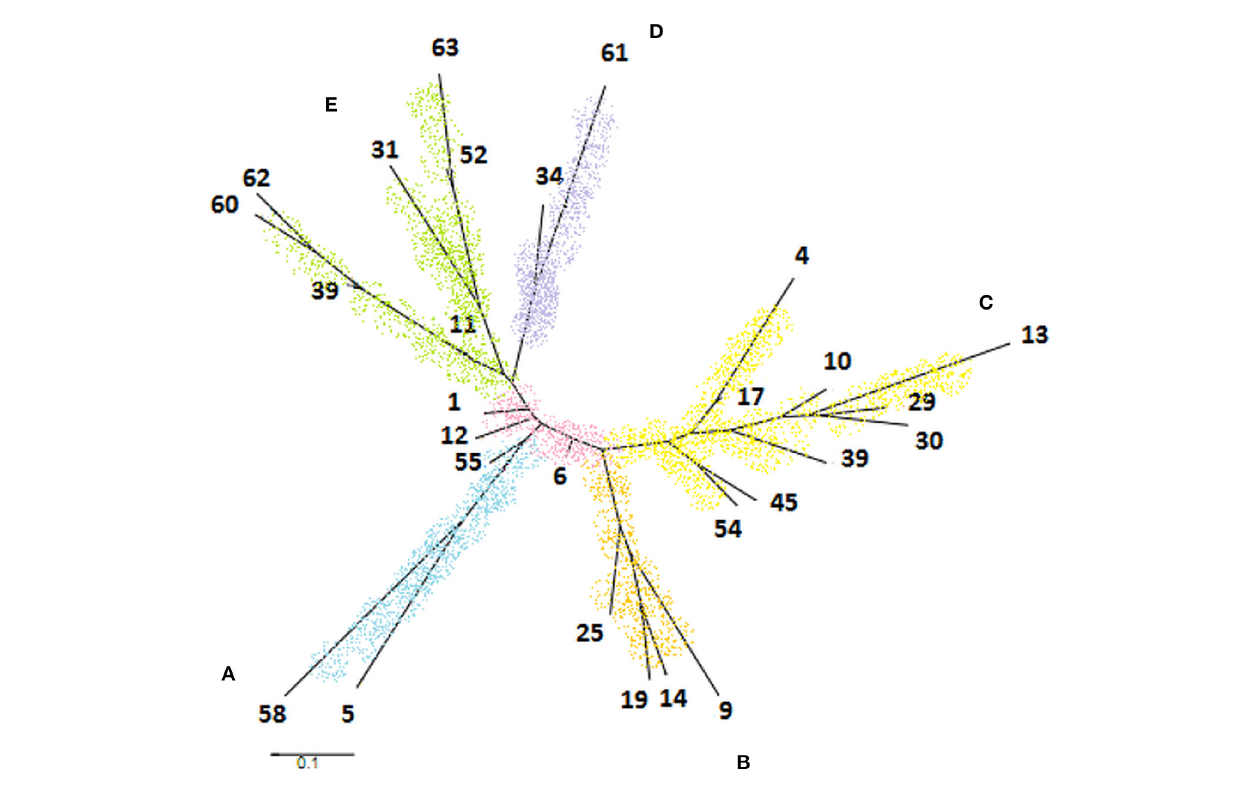
FIGURE 4 | Phylogenetic tree generated by PubMLST program based on 28 sequence types of Mycobacterium bovis obtained in the study. It was observed the formation of five clades identified by letters and colors as follows: clade A (blue), clade B (orange), clade C (yellow), clade D (purple), and clade E (green).